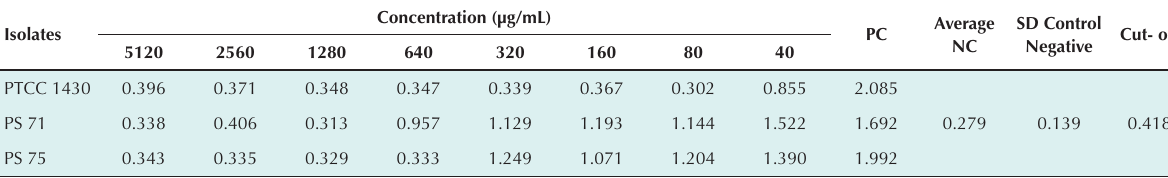
Table 2. OD Observation of Isolates Based on Quantitative MBEC in Various Concentrations of Antibiotics Isolates